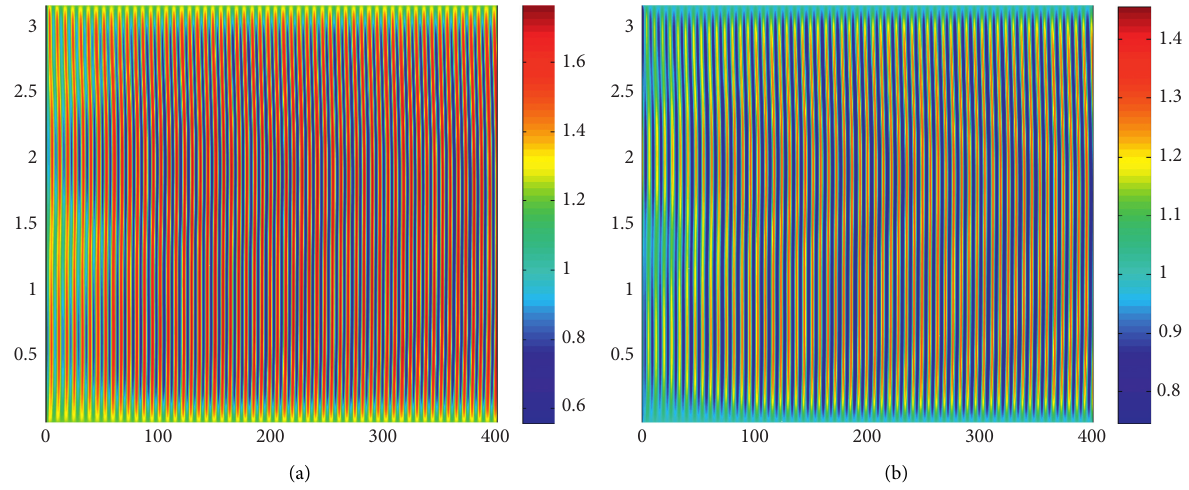
Figure 8: The spatial pattern of the system with Dirichlet boundary for τ ( t,x ) . (b) Spatial pattern of y y 1